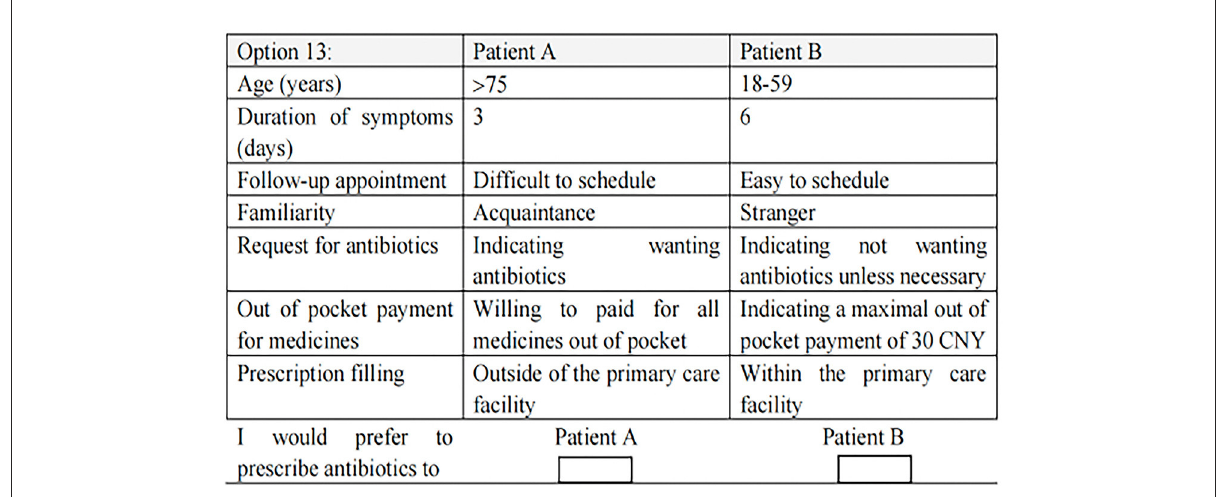
FIGURE1 An example of choice sets for the discrete choice